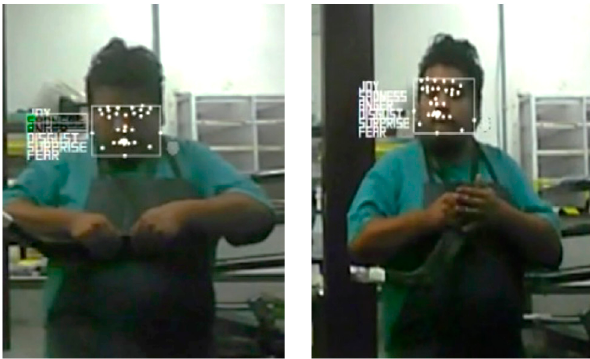
Figure 3. The employees were located within a range of three meters from the camera (0.3 yds) to perform active face tracking and continuously monitor their emotional states as can be observed.